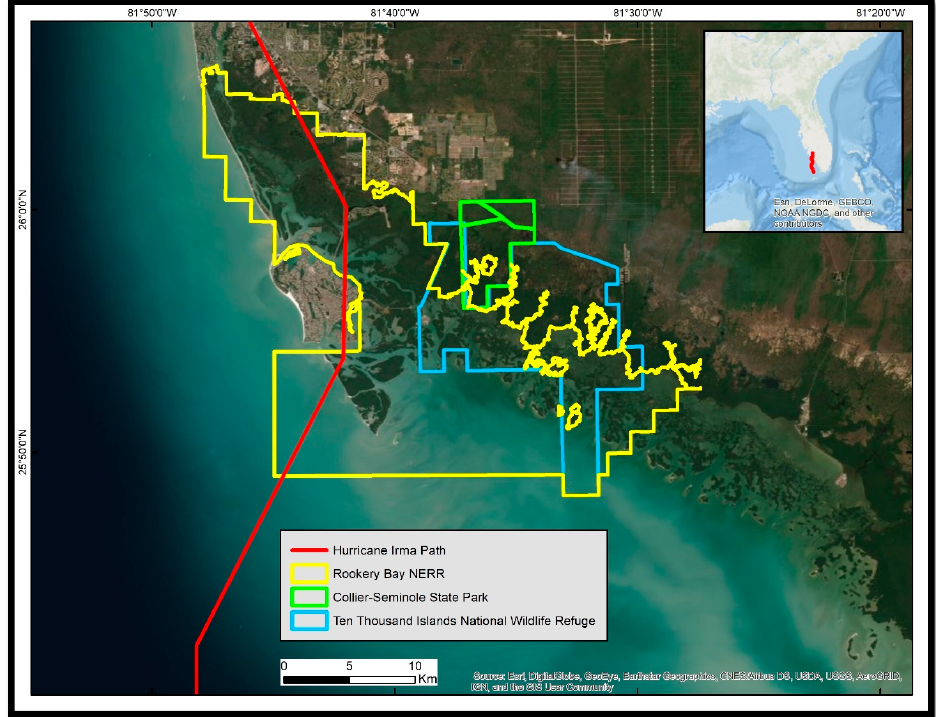
Figure 1. Southwest Florida, USA, showing the path of Hurricane Irma (red line in main graphic and in the inset showing the western Gulf of Mexico and the state of Florida; ArcGIS Basemap Source: ESRI). Local management jurisdiction boundaries are shown in different colors. NERR, National Estuarine Research Reserve. Remote Sens. 2020 , 12 , x FOR PEER REVIEW